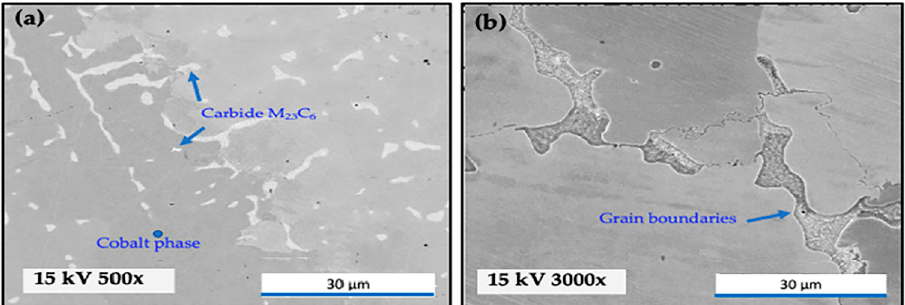
Figure 2. SEM images of polished surfaces of the Co-Cr-Mo alloy samples. ( a ) Dendritic structure, with an inter-dendritic carbide phase and ( b ) grain structure.